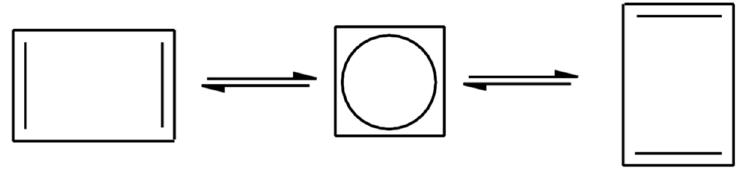
Figure 1. Automerization reaction of cyclobutadiene.